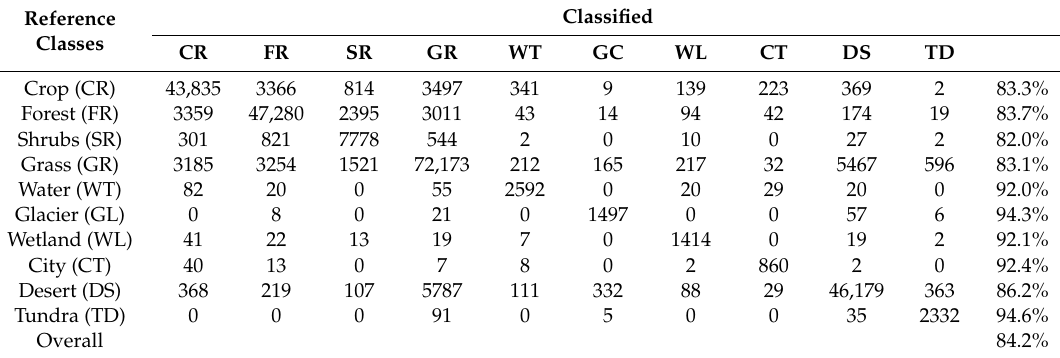
Table 4. Long time series land cover classification model precision confusion matrix.